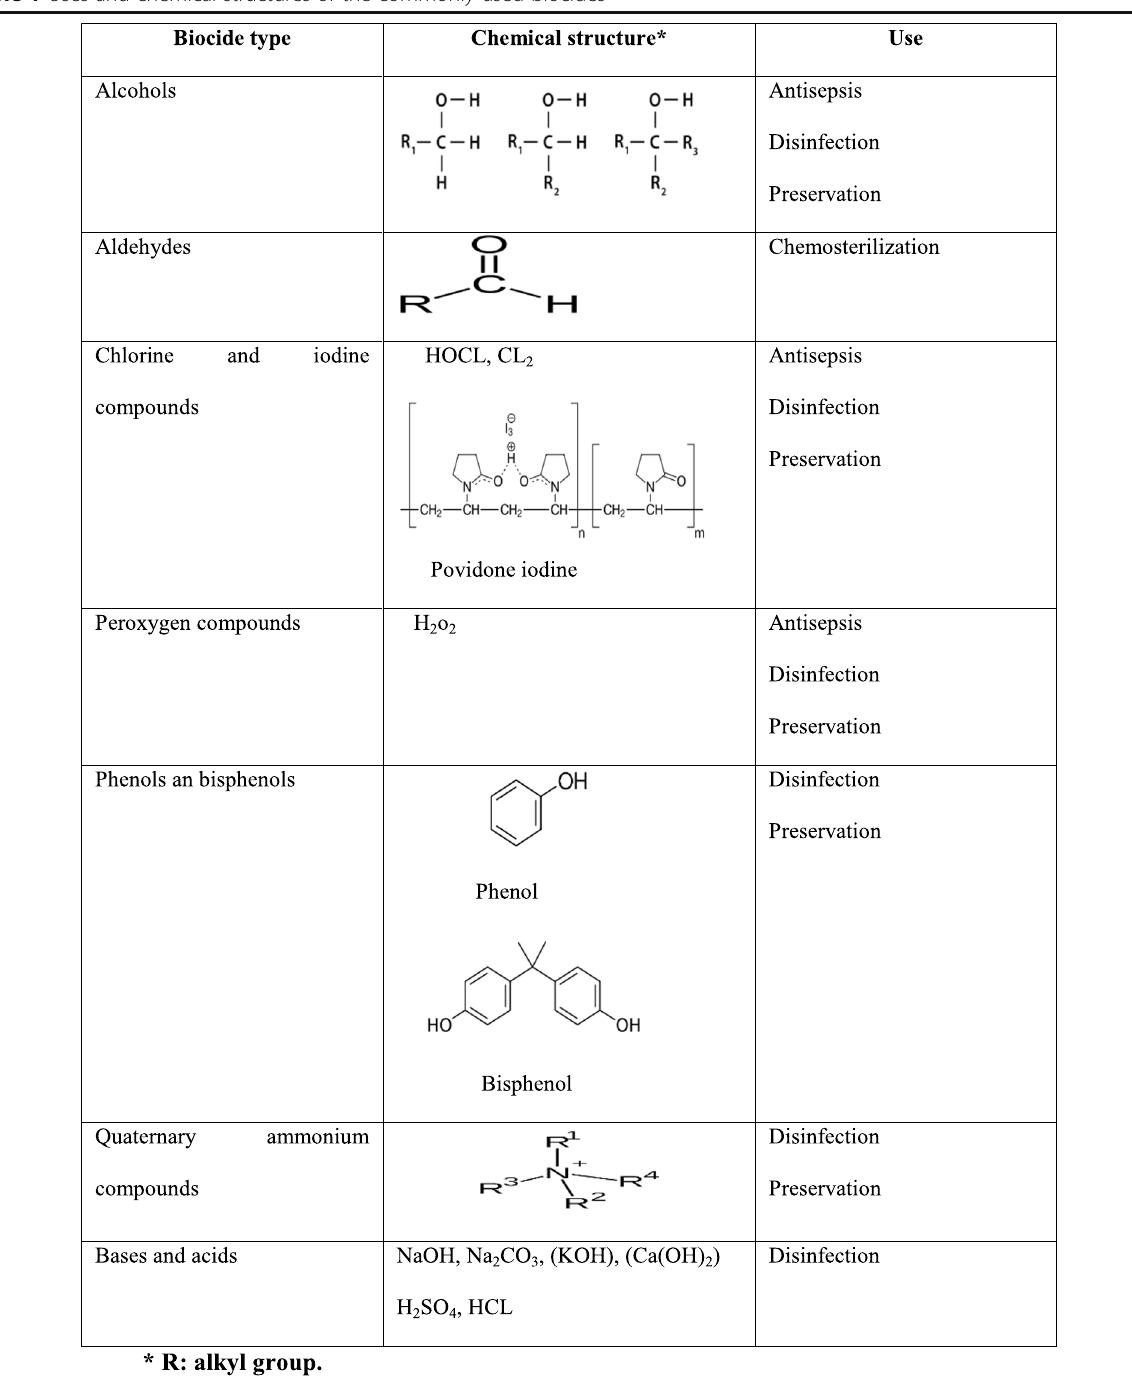
Table 1 Uses and chemical structures of the commonly used